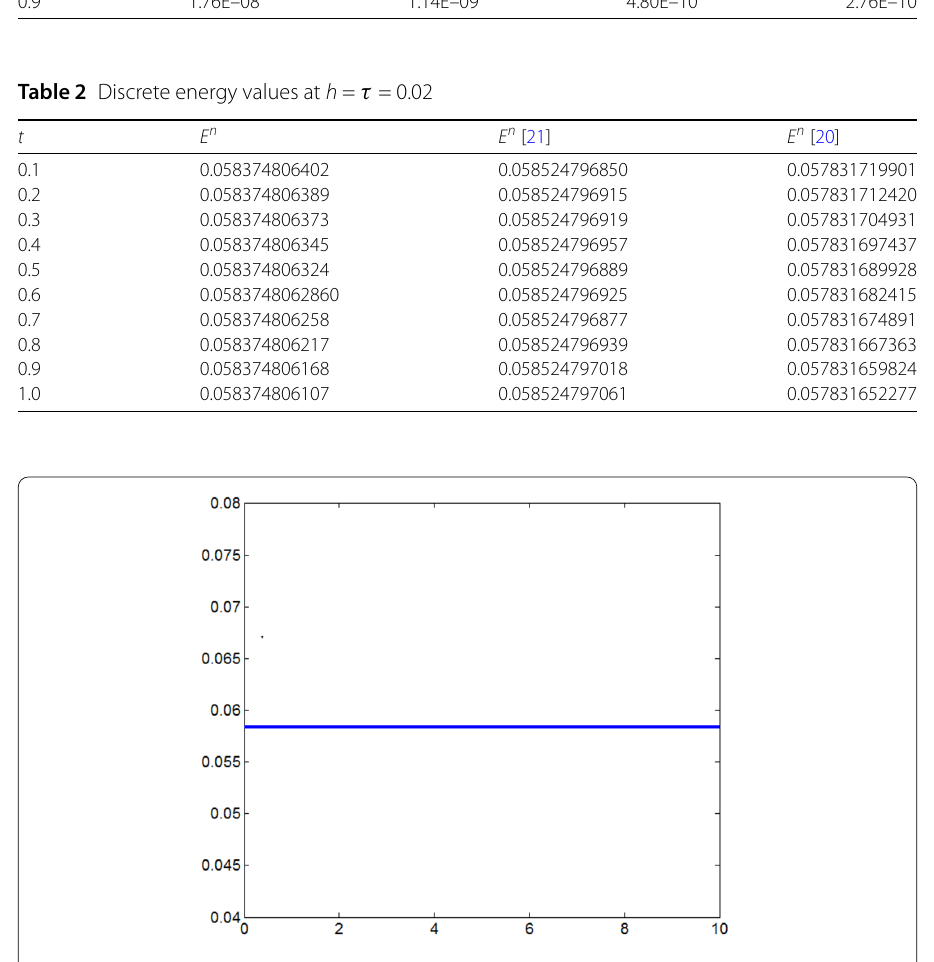
Figure 1 Energy conservation properties of (3.7) at J = 100, τ = 0.02, T =